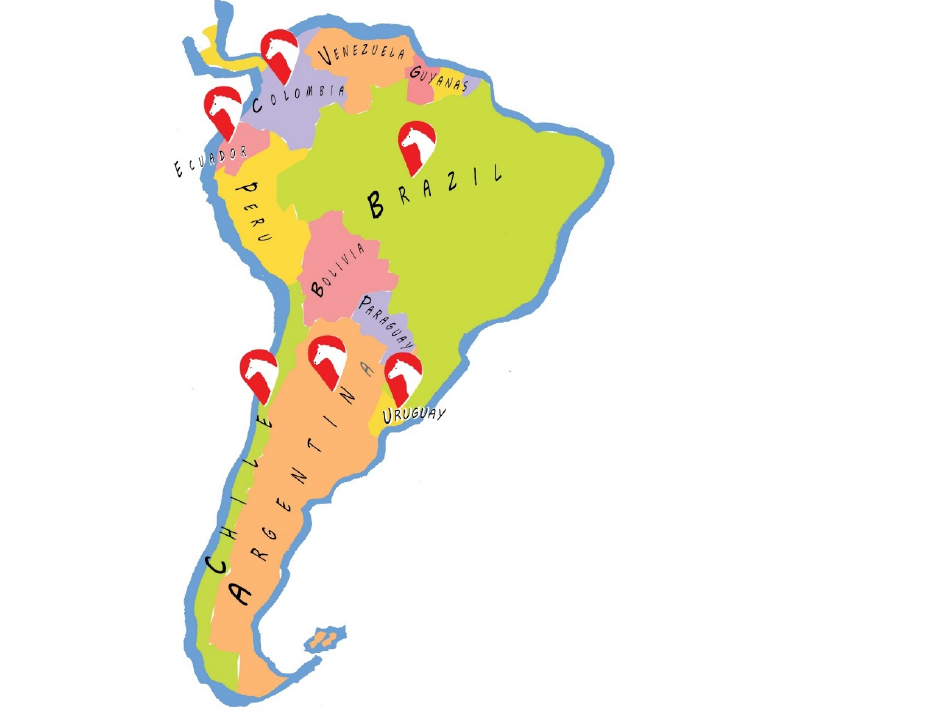
Figure 1. Geographical localization of the countries where EIV was reported in South America. Table 1. Summary of EIV outbreaks occurred in South America in chronological order.